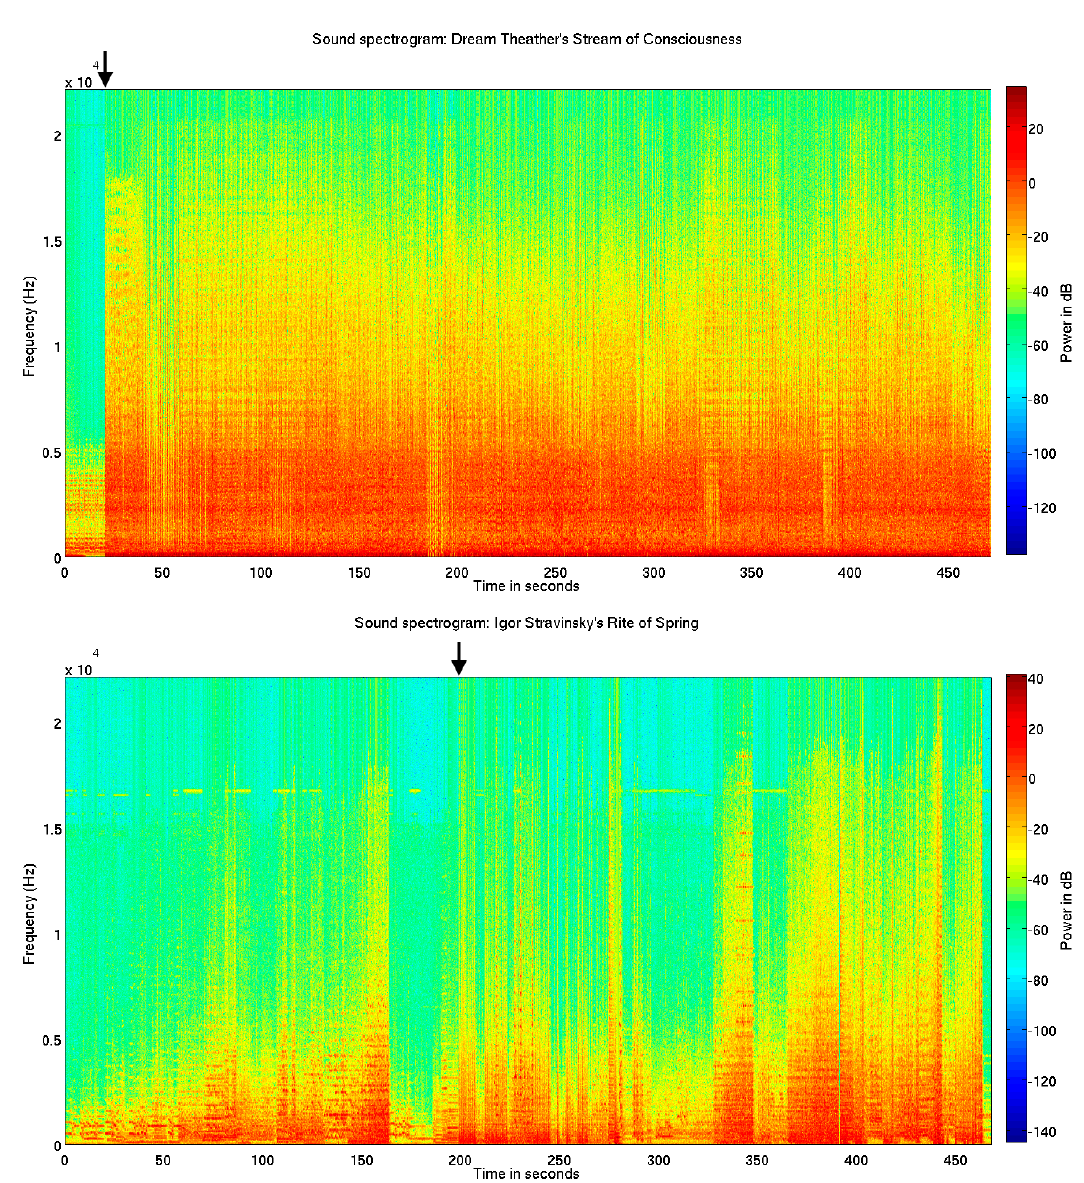
Figure 1. Sound spectrograms. Above is shown sound spectrograms for the metal/rock piece Stream of Consciousness (SC) ( top ) and the modern orchestral ballet music Rite of Spring (RS) ( bottom ). The novel loudness and brightness increase can be seen at 20.316 s ( top ), and the inharmonic frequency distribution of the unconventional polychord can be seen at 198.646 s ( bottom ).